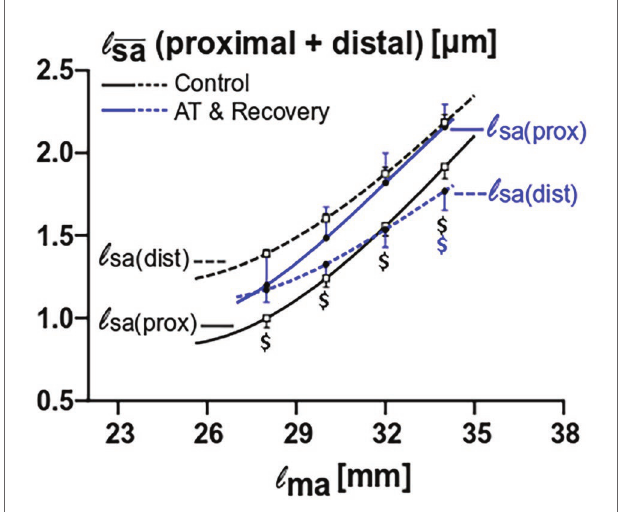
FIGURE 6 | Fiber mean sarcomere length comparison between proximal and distal muscle fibers for the control versus the aponeurotomy plus recovery group. Note that in control muscle, proximal fibers have lower mean sarcomere length than proximal fibers; these differences are indicated with black “$” ( p = 0.015), whereas in aponeurotomy plus recovery group the lines are reversed (proximal fibers have higher mean sarcomere lengths than distal fibers), and differences are indicated with blue “$” ( p = 0.015). All values are presented as mean and either plus or minus SEM; Two-way mixed ANOVA (with repeated measurements for muscle length) was used to check if the mean fiber sarcomere lengths were different between groups. Control n = 10, AT & recovery n =